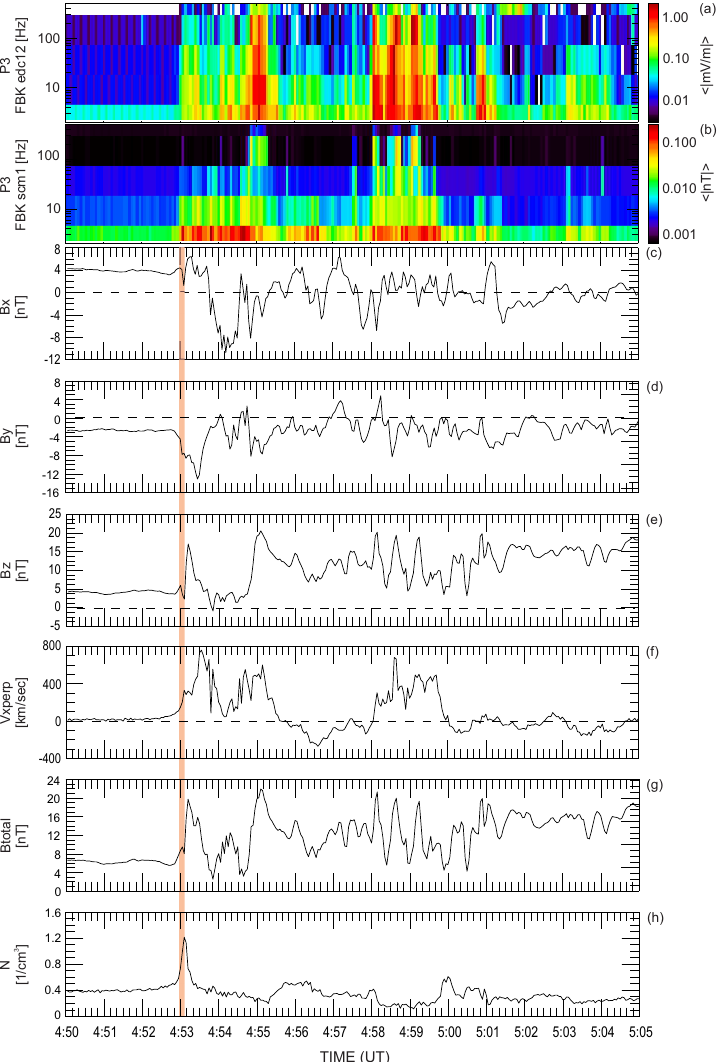
Fig. 2. An overview of wave power, magnetic field and plasma moments measurements from P3 spacecraft between 04:50–05:05UT on 26 February 2008. The first two panels are the on-board computed wave pseudo-power (mean amplitude) spectra obtained from the EFI and SCM instruments consisted of filter bank spectral bands covering the range from ∼ 2Hz to ∼ 500Hz. Magnetic field components B x , B y , and B z from FGM instrument are plotted in panels (c) , (d) , and (e) . Panel (f) presents the calculated earthward convective plasma flow derived from ESA measurements. Magnetic field intensity is plotted in panel (g) . Plasma density is shown in panel (h)